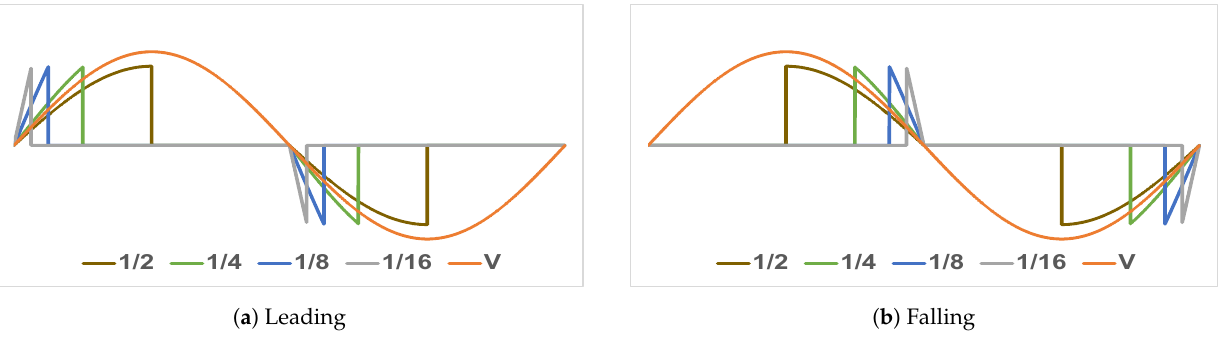
Figure 3. Crest factor tests